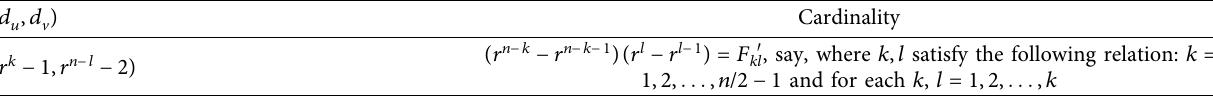
Table 7: Partition of pair of nodes ( u,v ) having distance 1.